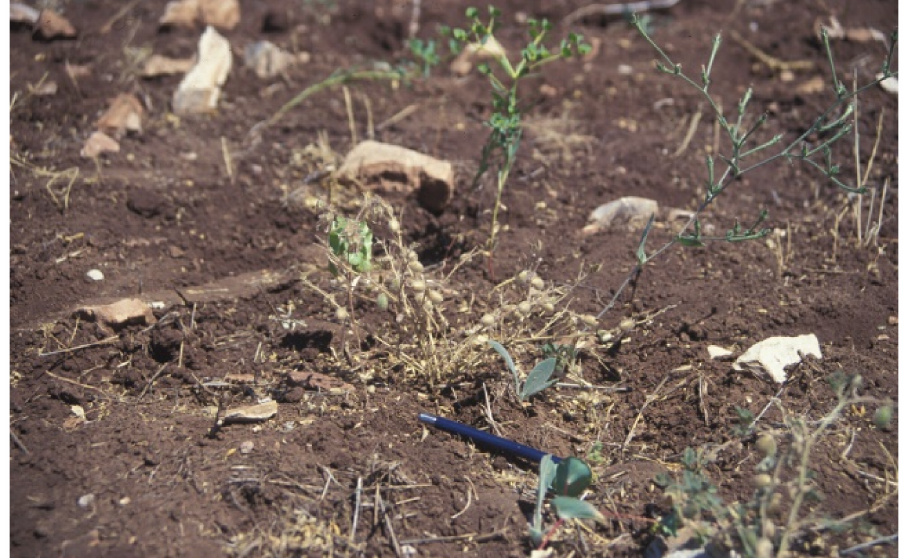
Figure 6. Two wild C. bijugum plants (center and right) after hand harvest of a lentil field near Midyat, southeast Turkey, June 2002. Note that the plants have retained their morphology and most of the pods, dry as well as partially green; in contrast to the (mechanically damaged) plants depicted in Figures 2 and 3 (photo by S.